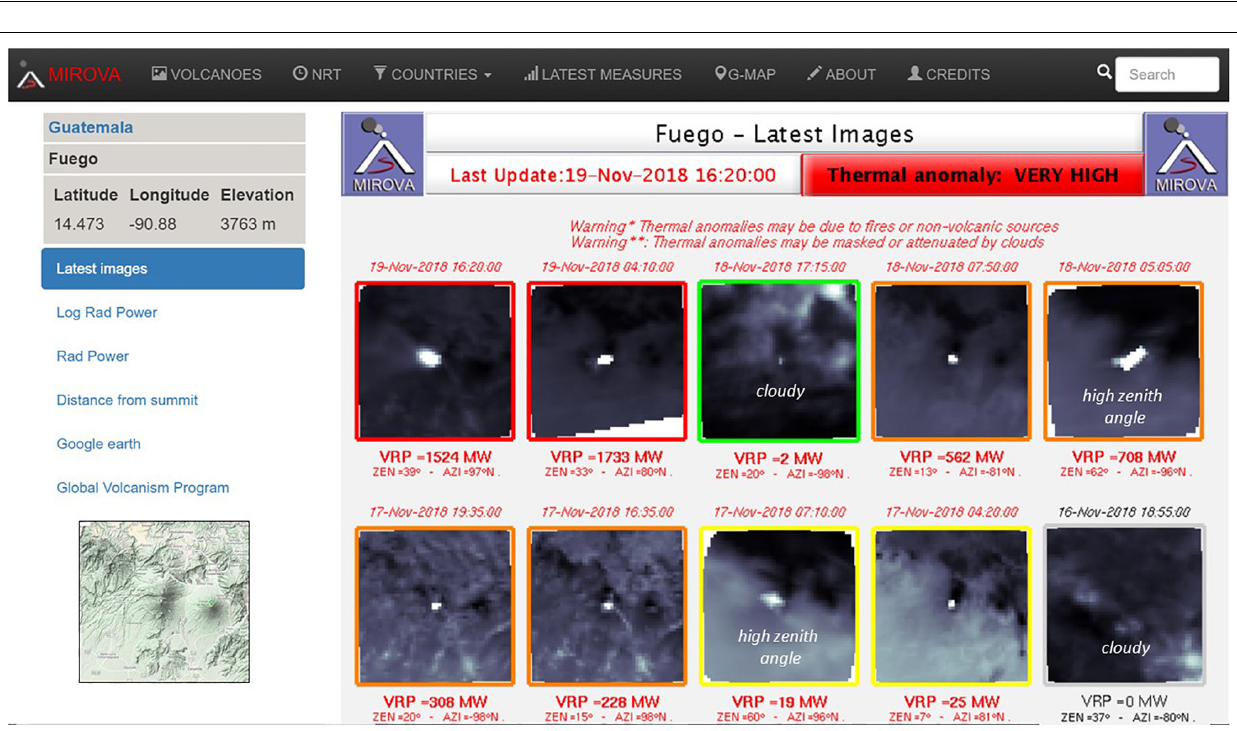
a vegetated area), anthropogenic source (e.g., located over an urban/industrial area), or it is a false alert (e.g., located above a body of